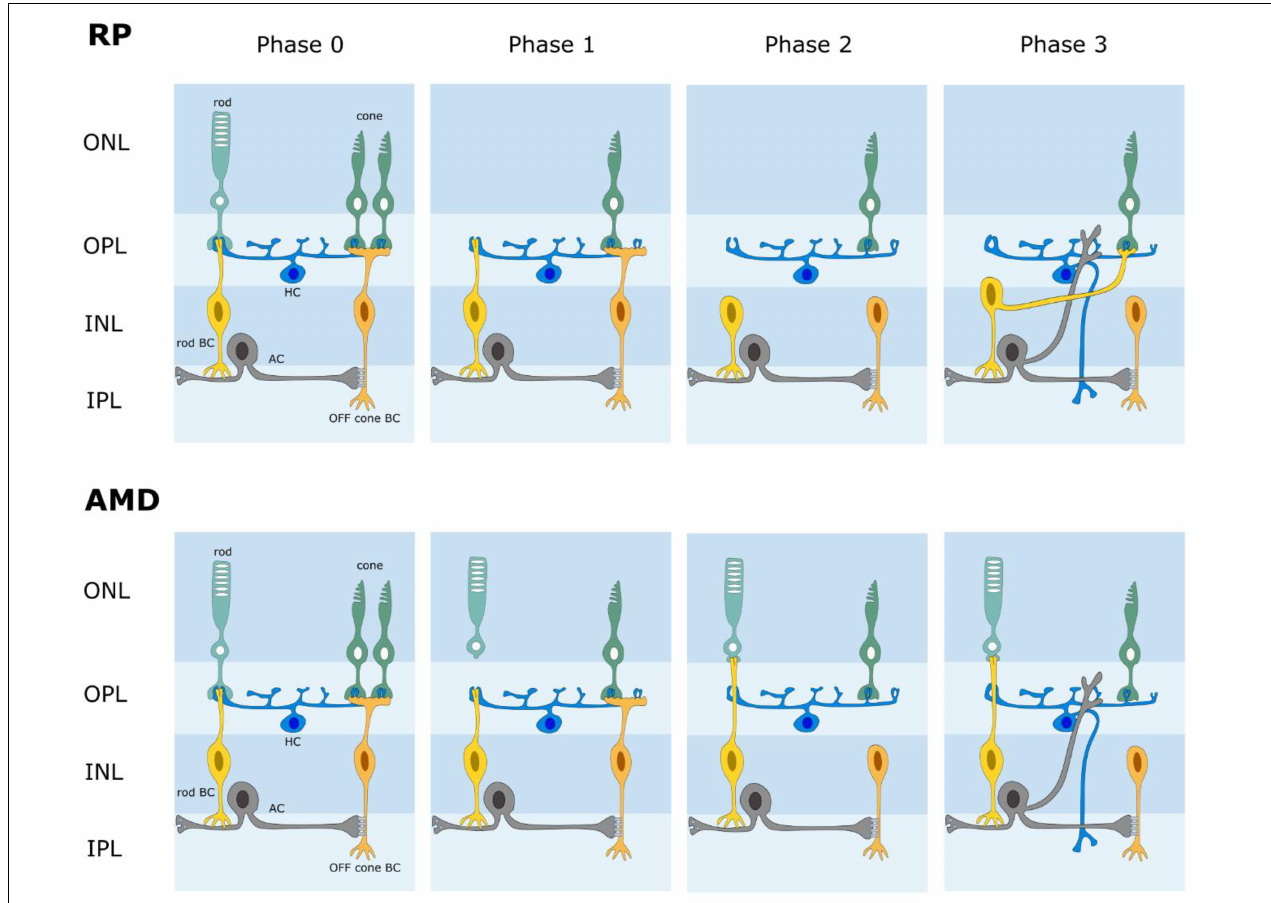
FIGURE 4 | Schematic diagram of retinal wiring stages following photoreceptor degeneration. AMD age-related macular degeneration. RP retinitis pigmentosa. In both AMD and RP, the retina undergoes a phased loss of cells and rewiring of its circuits. Phase 0 is normal retina. Phases 1-3 illustrate some changes that